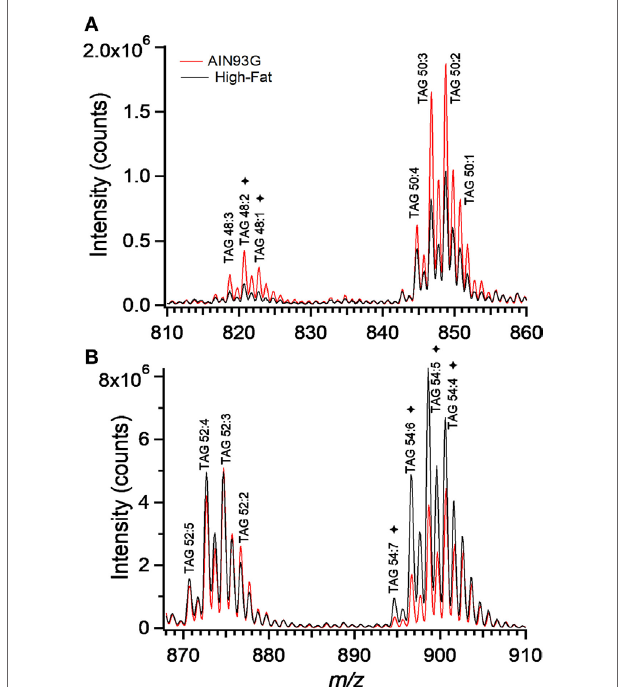
FigUre 7 | Enhanced mass spectrum for triacylglycerols (TAG) 48 and TAG50 (a) and TAG52 and TAG54 (b) . Note the higher concentrations of C48 and polyunsaturated C54 containing TAG species in tumors from the AIN93G (a) and high-fat diet (b) fed mice, respectively. *denote significant differences in TAG species as determined by volcano plot analysis ( Figure 6 ).